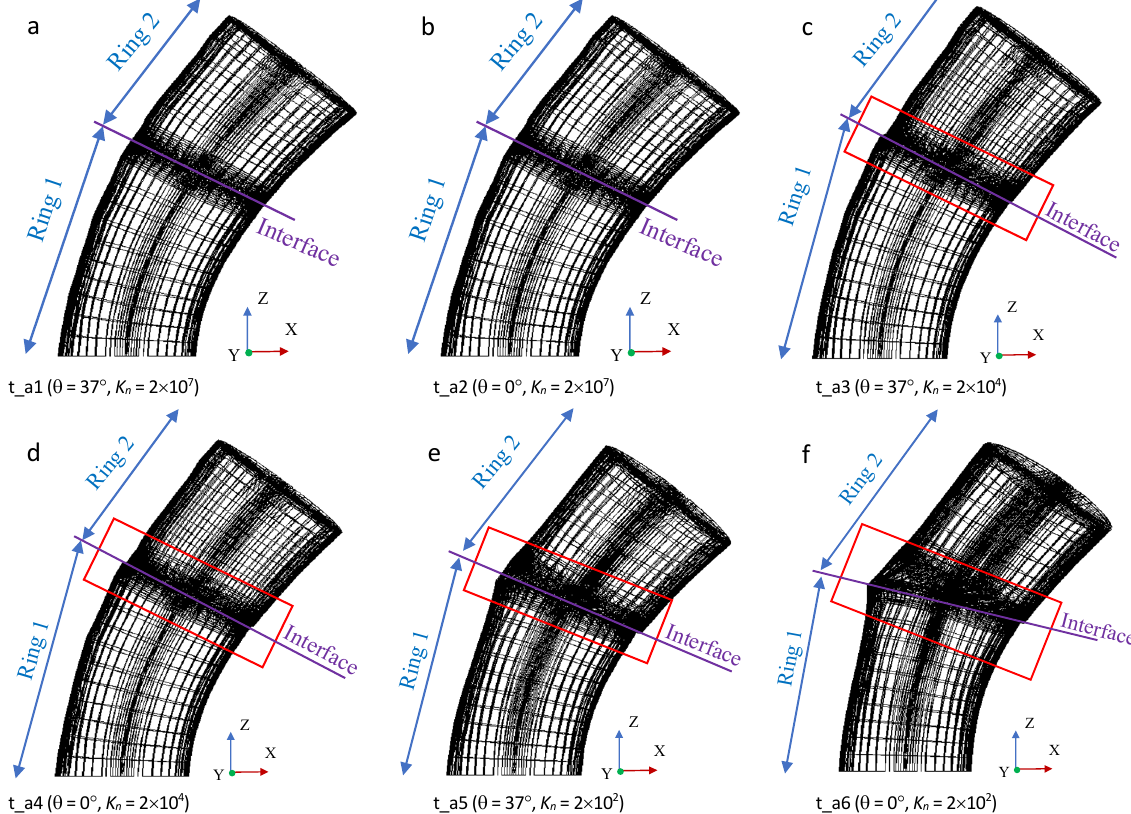
Figure 16. Influence of the friction angle of the concrete ‐ concrete contact on the deformation of models for normal stiffness of: (a) ‐ (c) 2  10 7 N/mm, and (d) ‐ (f) 2  10 4